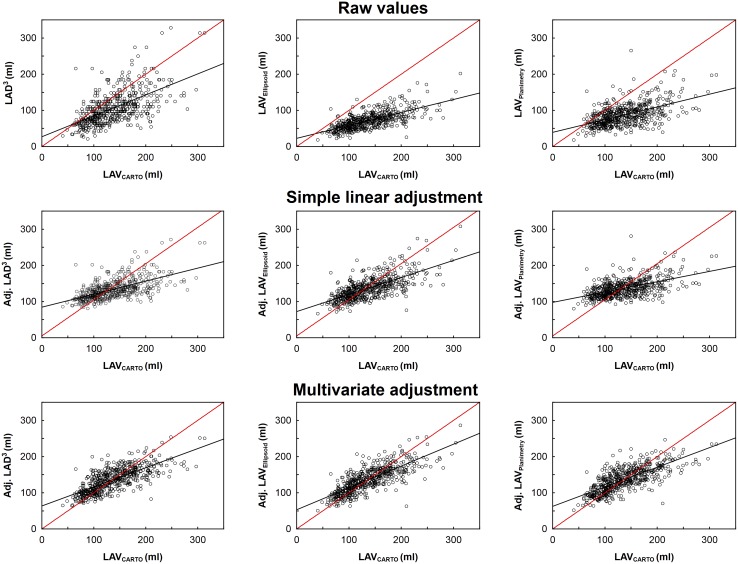
Correlation of raw and adjusted 2D-ECHO-based LAV with CARTO-derived LAV.Upper row: raw values. Middle row: simple linear adjustment. Lower row: multivariate adjustment for clinical covariates. Regression coefficients from Tables 2 and 3 were used for the simple and multivariate adjustment, respectively. Specifically, adjusted LAV was calculated as:68 + 0.62 LAD3;42 + 1.32 LAVEllipsoid;66 + 0.81 LAVPlanimetry;67 + 0.42 LAD3 + 15 (if male) + 0.44 Age + 34 (if persistent AF) + 14 (if SHD);49 + 0.98 LAVEllipsoid + 12 (if male) + 0.34 Age + 32 (if persistent AF) + 10 (if SHD);64 + 0.60 LAVPlanimetry + 18 (if male) + 0.38 Age + 40 (if persistent AF) + 14 (if SHD).Red line–identity line; black line–regression line. Adj = adjusted. Other abbreviations as in Fig 1.